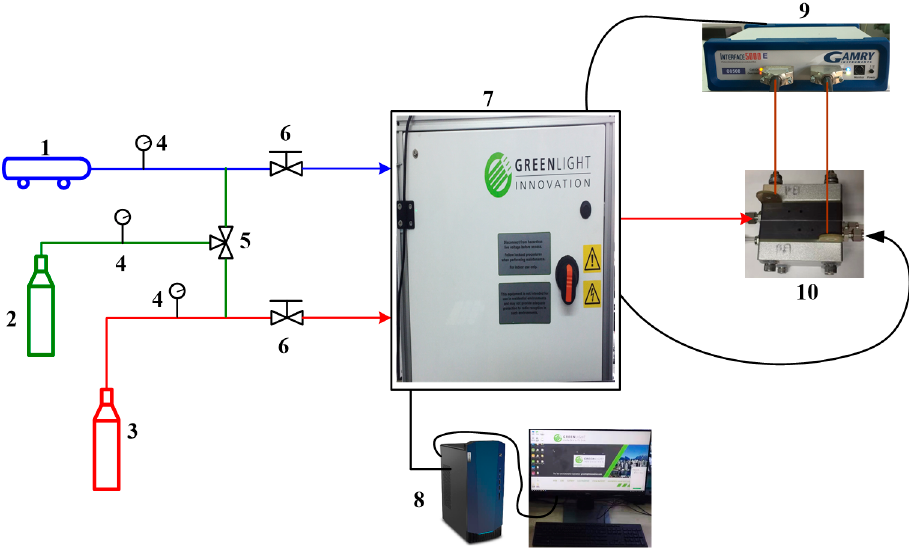
Figure 1. Schematic diagram of the experimental platform (1. air compressor, 2. N 2 , 3. H 2 , 4. pressure gauge, 5. triple valve, 6. reducing valve, 7. G20, 8. desktop, 9. electrochemical workstation, 10. PEMFC).